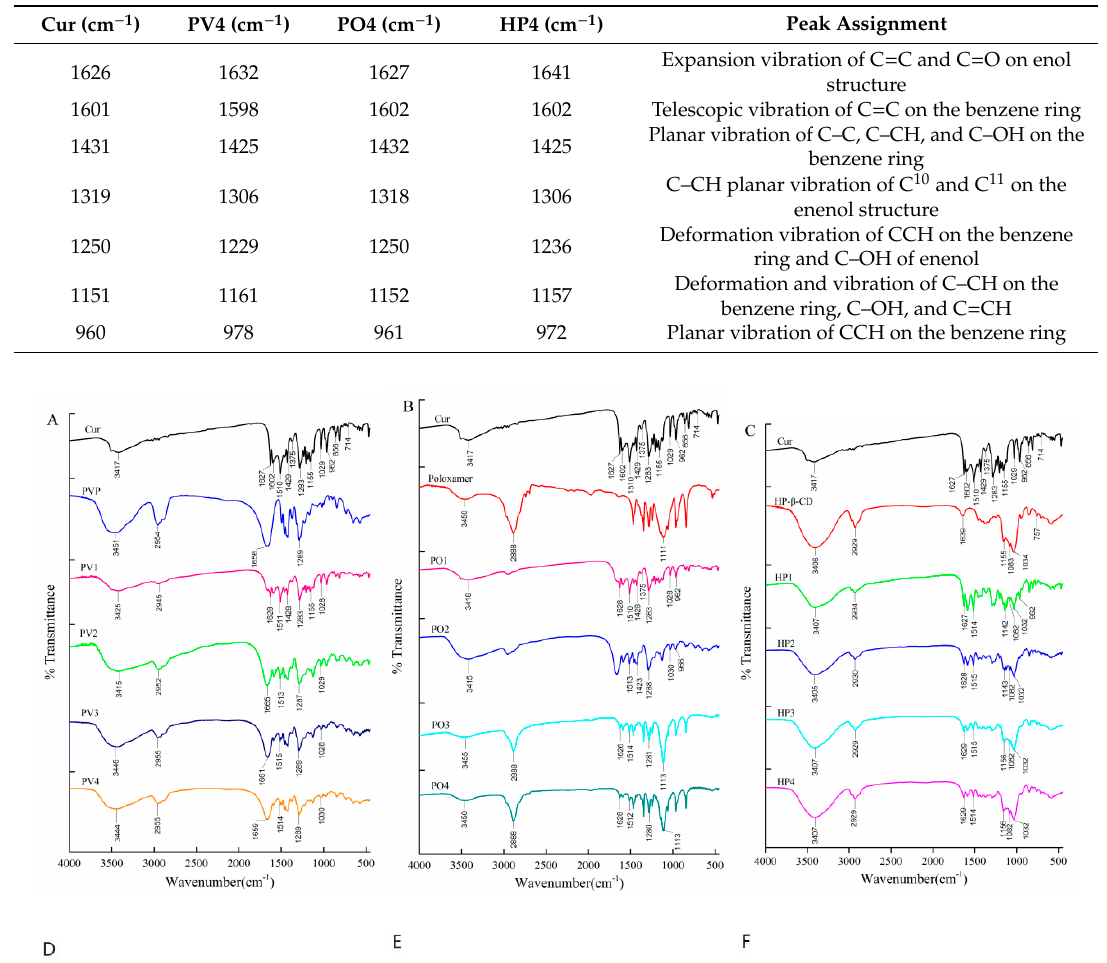
Table 1. The Raman spectrum peak of Curcumin and its solid preparations.